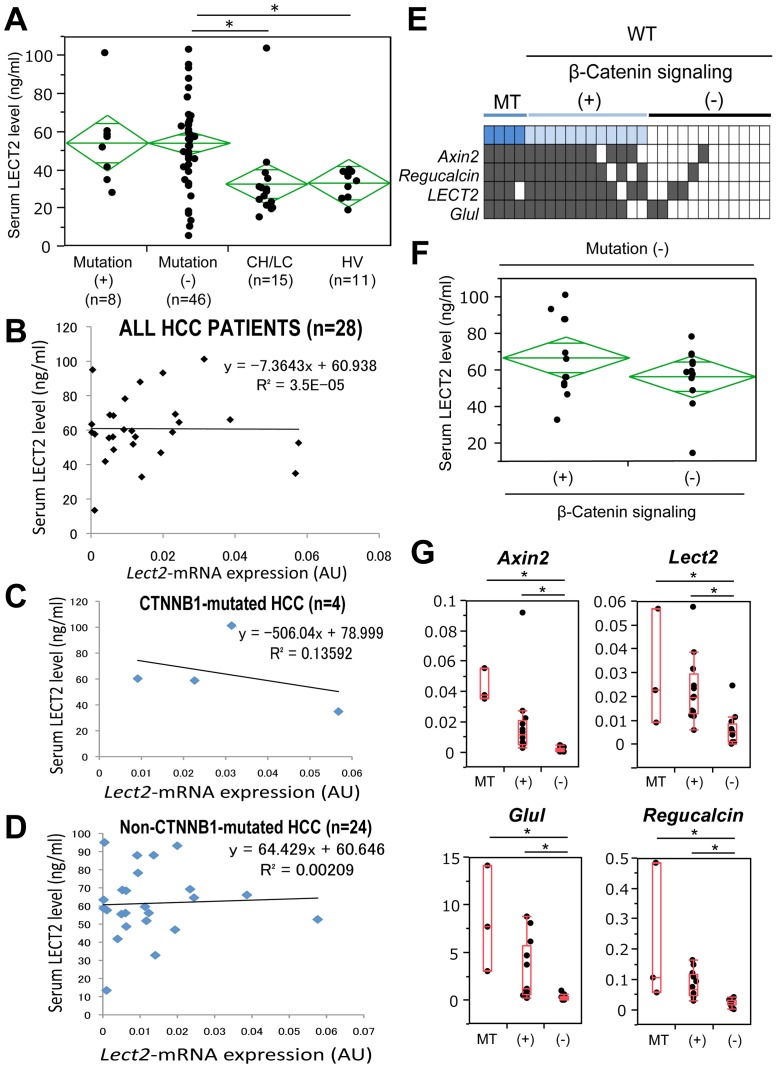
No correlation of β-catenin mutations or β-catenin activation to serum LECT2 levels in patients.A. Serum LECT2 levels in patients with HCC with CTNNB1 mutations, absent CTNNB1 mutations, patients with chronic liver fibrosis (CH/LC), and healthy volunteer (HV) as assessed by ELISA. (*p<0.05). B. No correlation observed between LECT2 expression in tumor and serum levels of LECT2 in HCC patients (n = 28). C. No correlation observed between LECT2 expression in β-catenin mutated tumors and serum levels of LECT2 in these HCC patients (n = 4). D. No correlation observed between LECT2 expression in non-β-catenin mutated tumors and serum levels of LECT2 in these HCC patients (n = 24). E. Heat map shows expression of β-catenin target genes in β-catenin-mutated (MT) and non-mutated wild-type (WT) HCC patients (n = 28). Genes assessed included AXIN2, REGUCALCIN, LECT2, and GLUL. (+) indicates β-catenin activity as seen by increased expression of at least 2 target genes whereas (−) indicates absent β-catenin activation reflected by lack of target gene expression. F. Serum LECT2 levels showed insignificant difference in HCC patients that lacked β-catenin gene mutations but showed high expression of β-catenin target genes versus patients who have neither β-catenin gene mutations nor any increase in β-catenin target gene expression. G. β-Catenin target gene expression shown by qRT-PCR. Steel-Dwass test was performed to compare the values among three groups. *, p<0.05. (+) indicates β-catenin activity as seen by increased expression of at least 2 target genes whereas (−) indicates lack of β-catenin activity due lack of target gene expression.